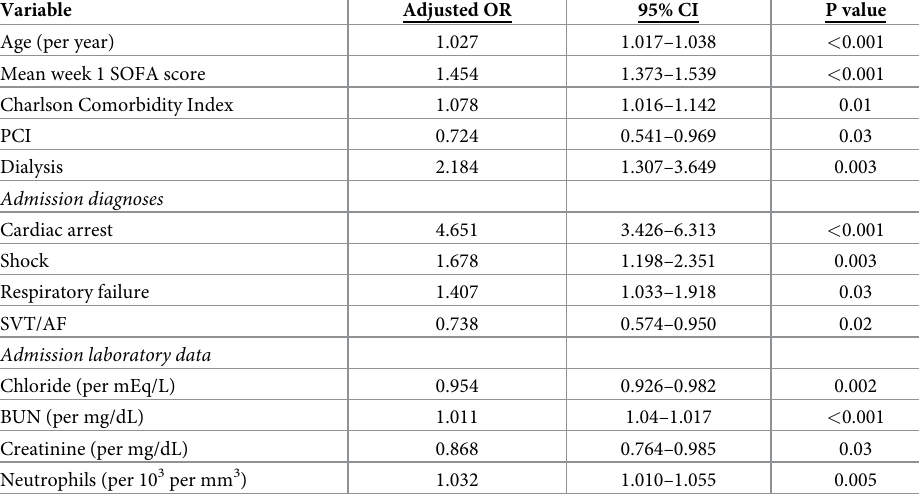
Table 2. Predictors of hospital mortality on multivariable elastic net regression. Only predictors with p < 0.1 are shown. Additional predictors included in the model were female gender, white race, BMI, APACHE-III score, prior stroke, prior HF, prior stroke, prior CKD, prior diabetes, prior liver disease, prior lung disease, prior dialysis invasive ventilator, noninvasive ventilator, RBC transfusion, PAC, IABP, coronary angiography, CRRT, number of vasoactive drugs, admission diagnosis of sepsis, admission diagnosis of VT/VF, admission diagnosis of ACS, admission systolic BP, admission HR, admission oxygen saturation, admission respiratory rate, admission MAP, admission GCS, admis- sion hemoglobin, admission sodium, admission potassium, admission bicarbonate. Candidate variables not included in the model were prior cancer, admission diastolic BP, admission WBC count, admission diagnosis of CS, and admis- sion diagnosis of HF. Final model AUC = 0.937.